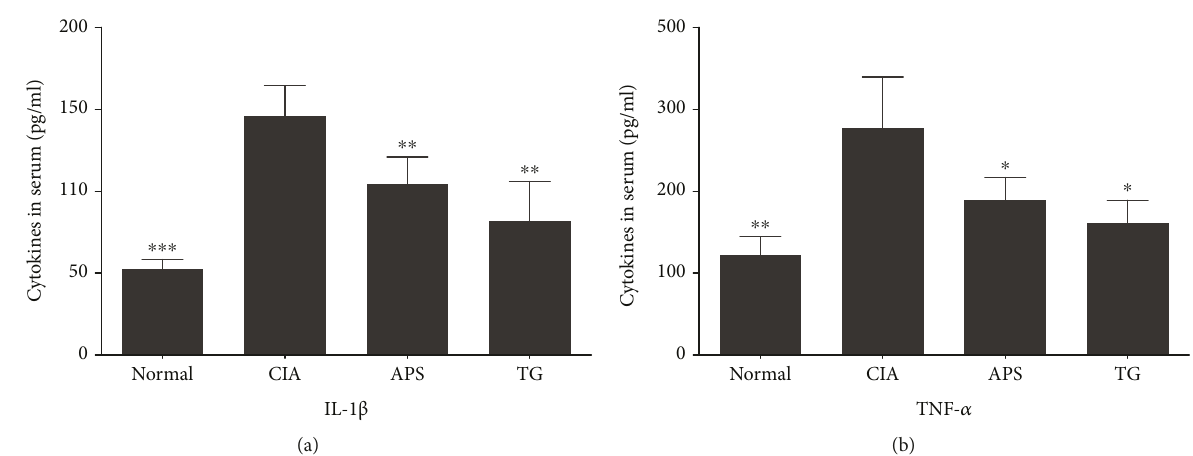
Figure 4: Serum levels of proin fl ammatory cytokines after 2 weeks of drug administration in type II collagen-induced arthritis (CIA) rats and vehicle rats. (a) Serum IL-1 β levels. (b) TNF- α levels. Data represent the mean ± SD of 6 rats per group. Signi fi cant e ff ect compared to the CIA group: ∗ P < 0 05 , ∗∗ P < 0 01 , ∗∗∗ P < 0 001 .